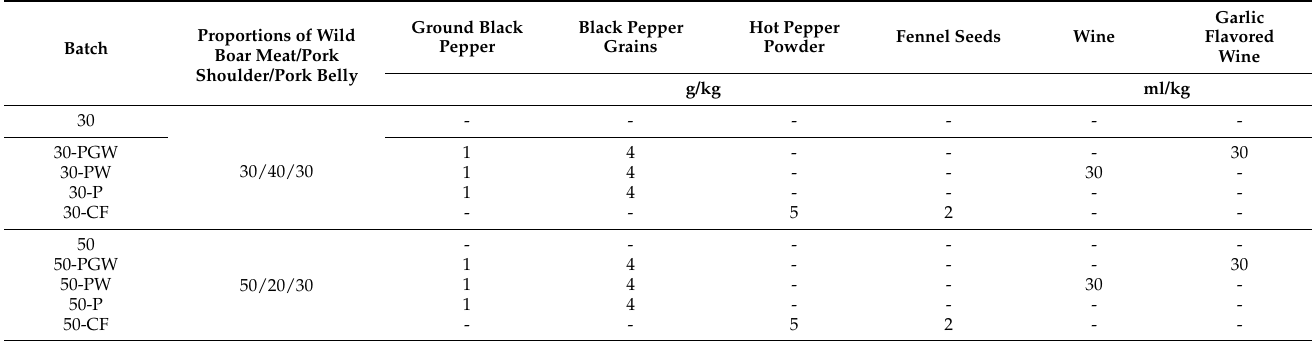
Table 1. Ingredients utilized in the ten